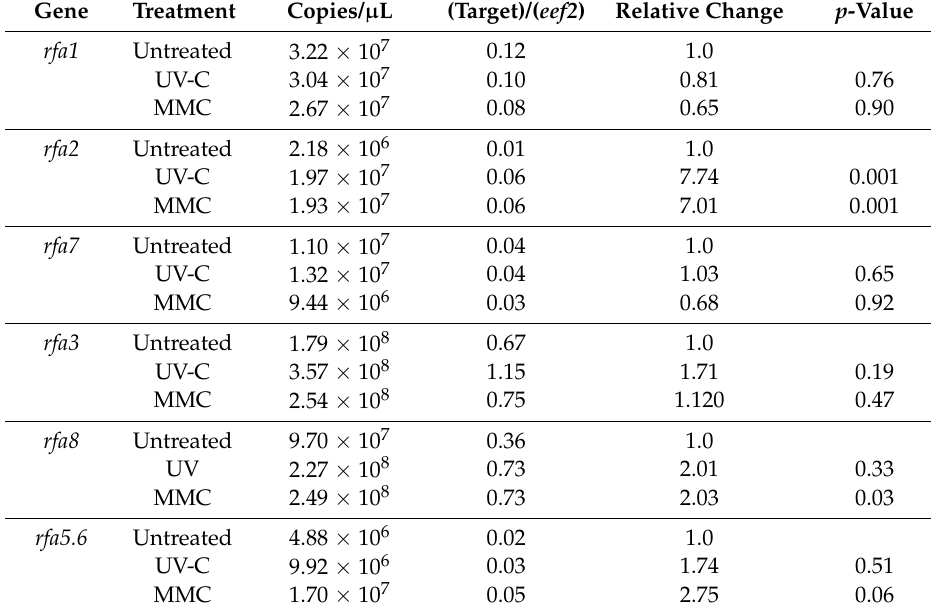
Table 5. Absolute levels and relative in expression of RPA genes 3 hours following treatment with UV-C or mitomycin C (MMC). Relative change to the untreated RPA genes based on expression values normalized to the corresponding maintenance gene eef2